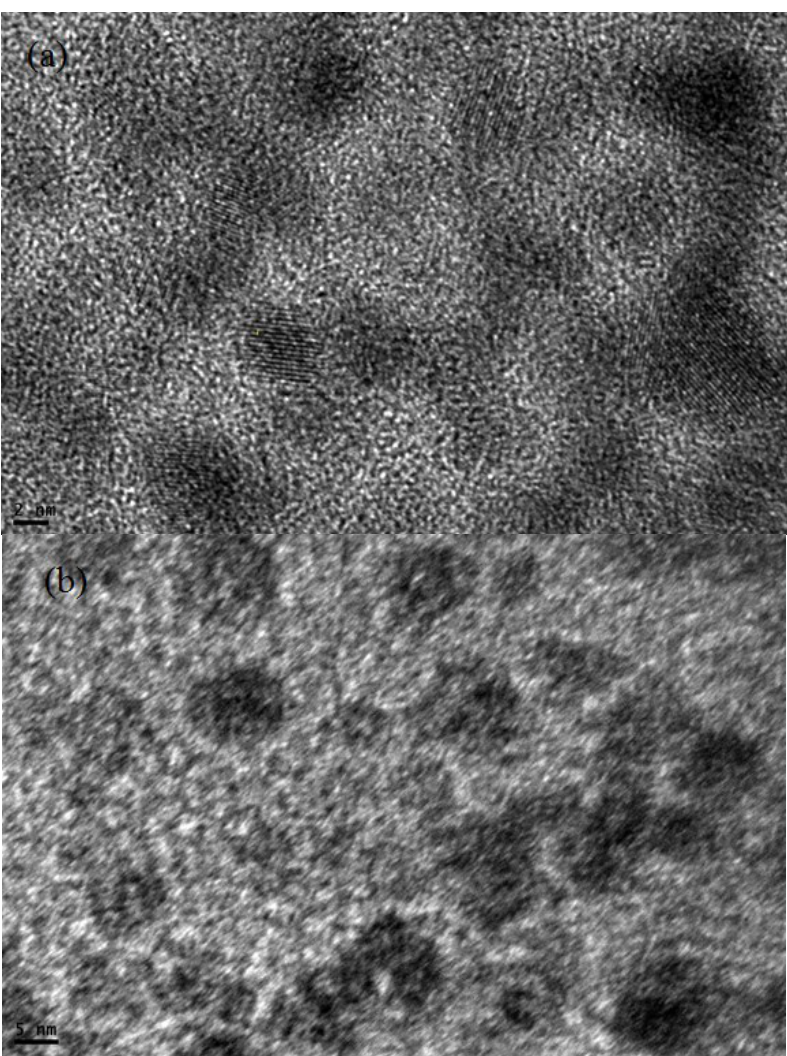
Figure 2. TEM images of CdS QD ( a ) low resolution ( b ) high